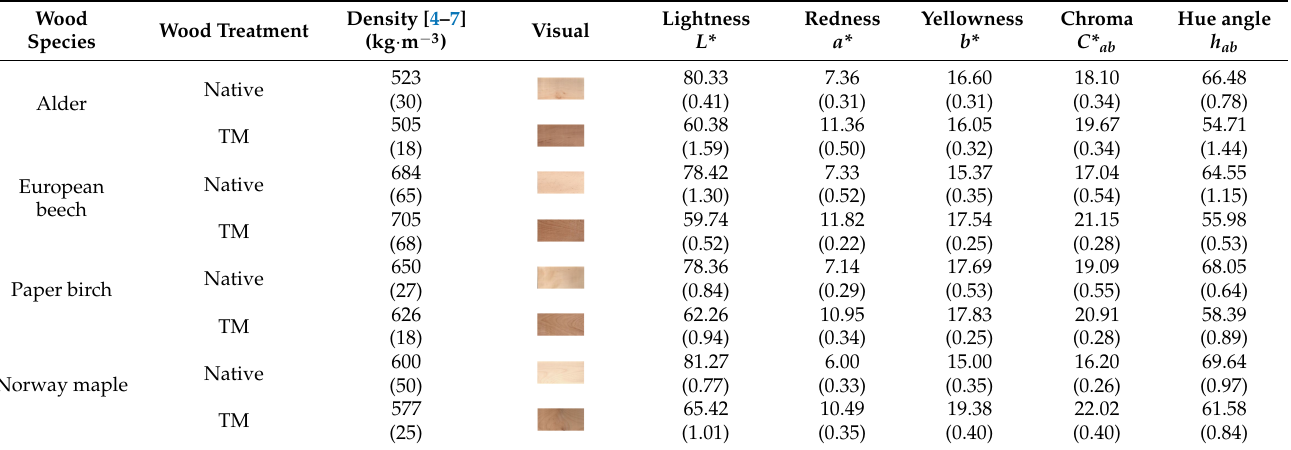
Table 3. Visualization and initial colorimetric parameters of